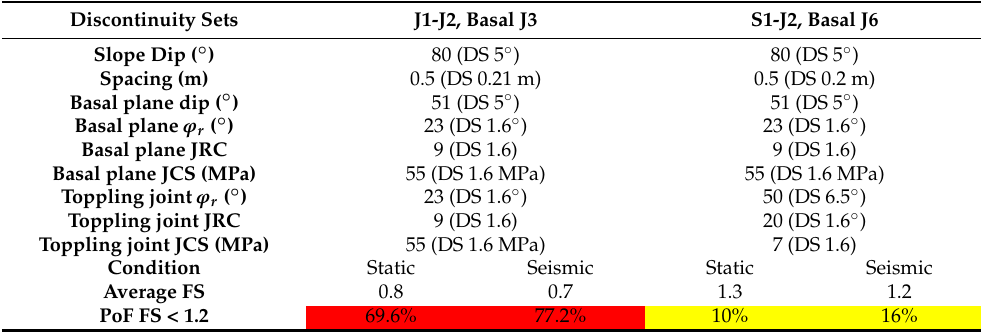
Table 14. Probabilistic stability analysis results for direct